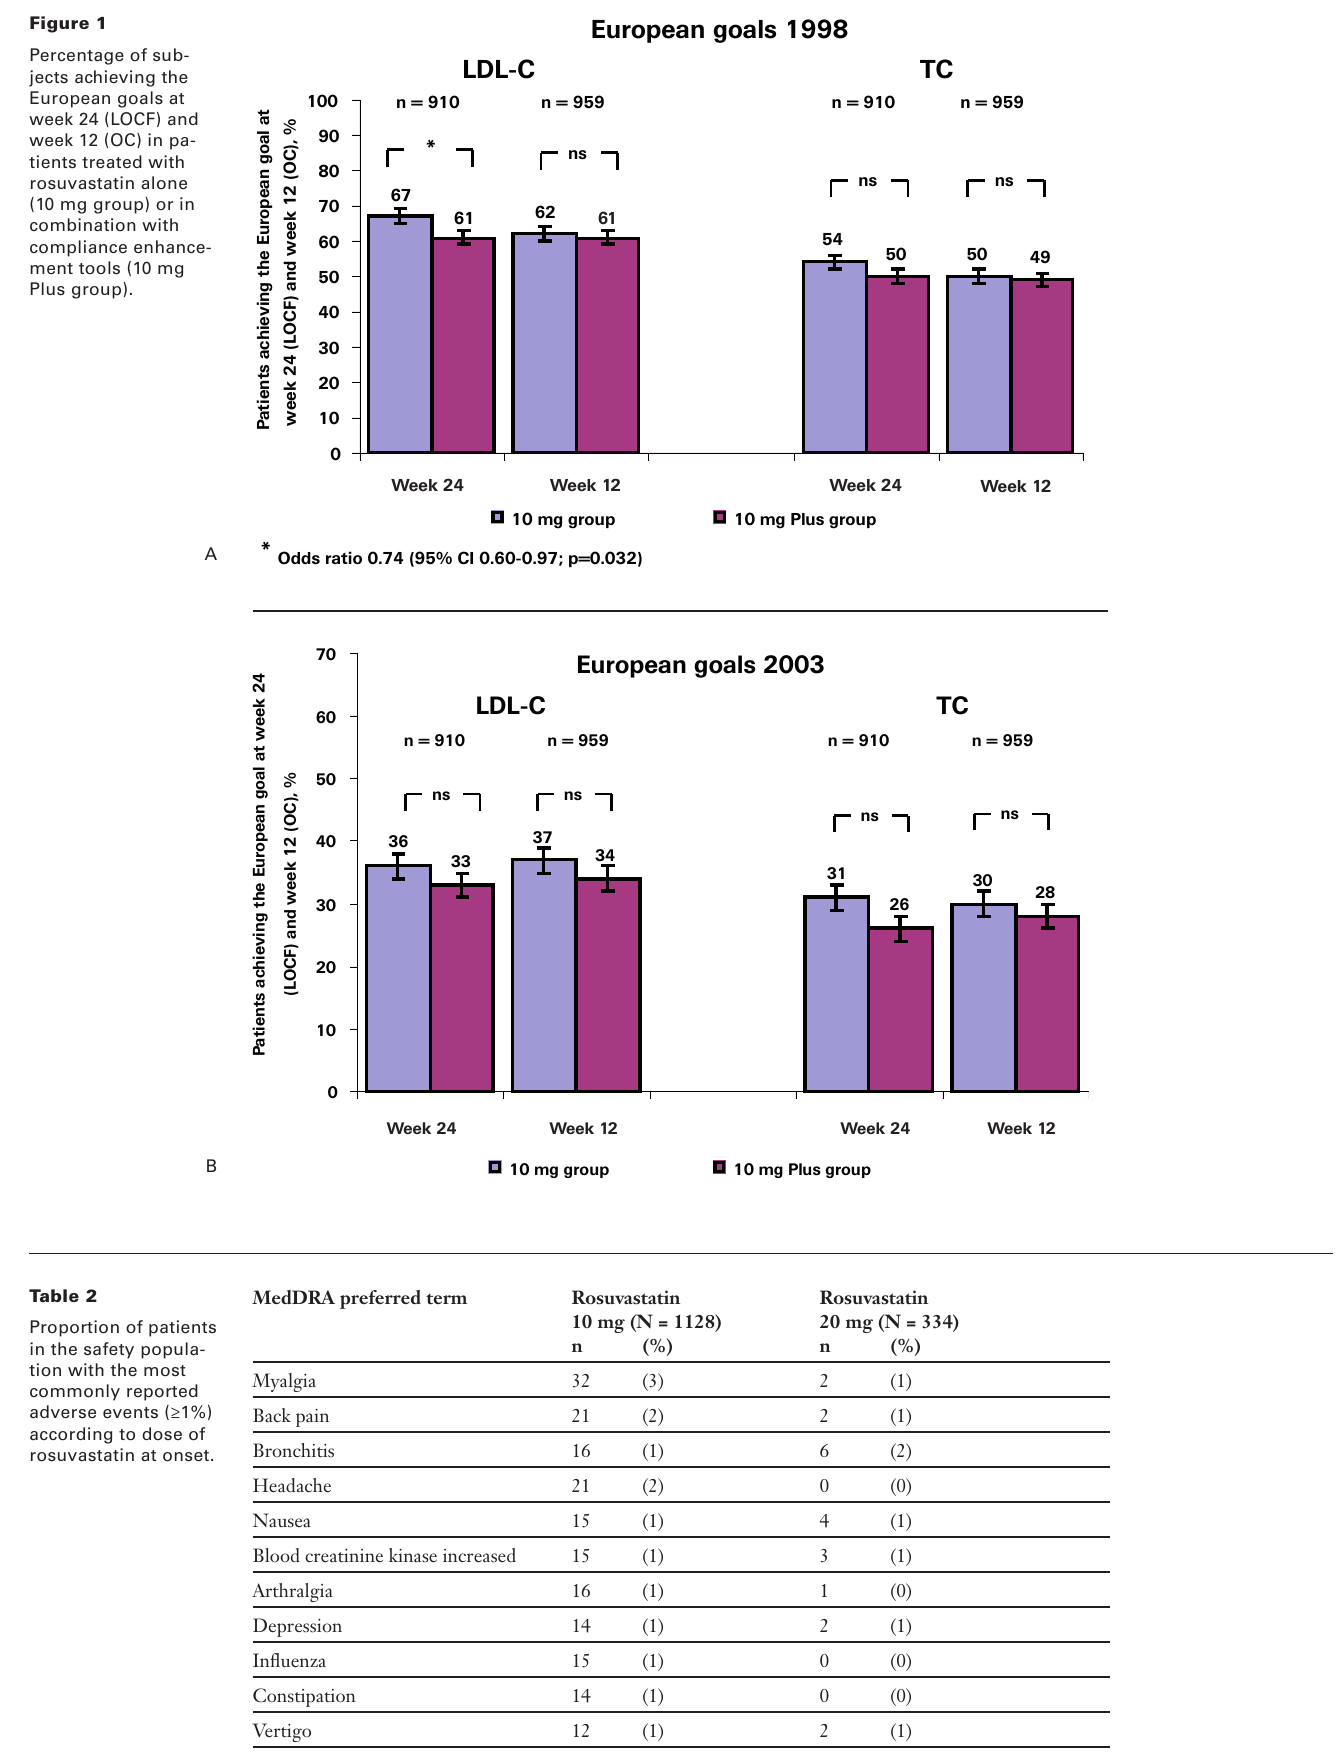
Figure 1 Percentage of sub- jects achieving the European goals at week 24 (LOCF) and week 12 (OC) in pa- tients treated with rosuvastatin alone (10 mg group) or in combination with compliance enhance- ment tools (10 mg Plus group).